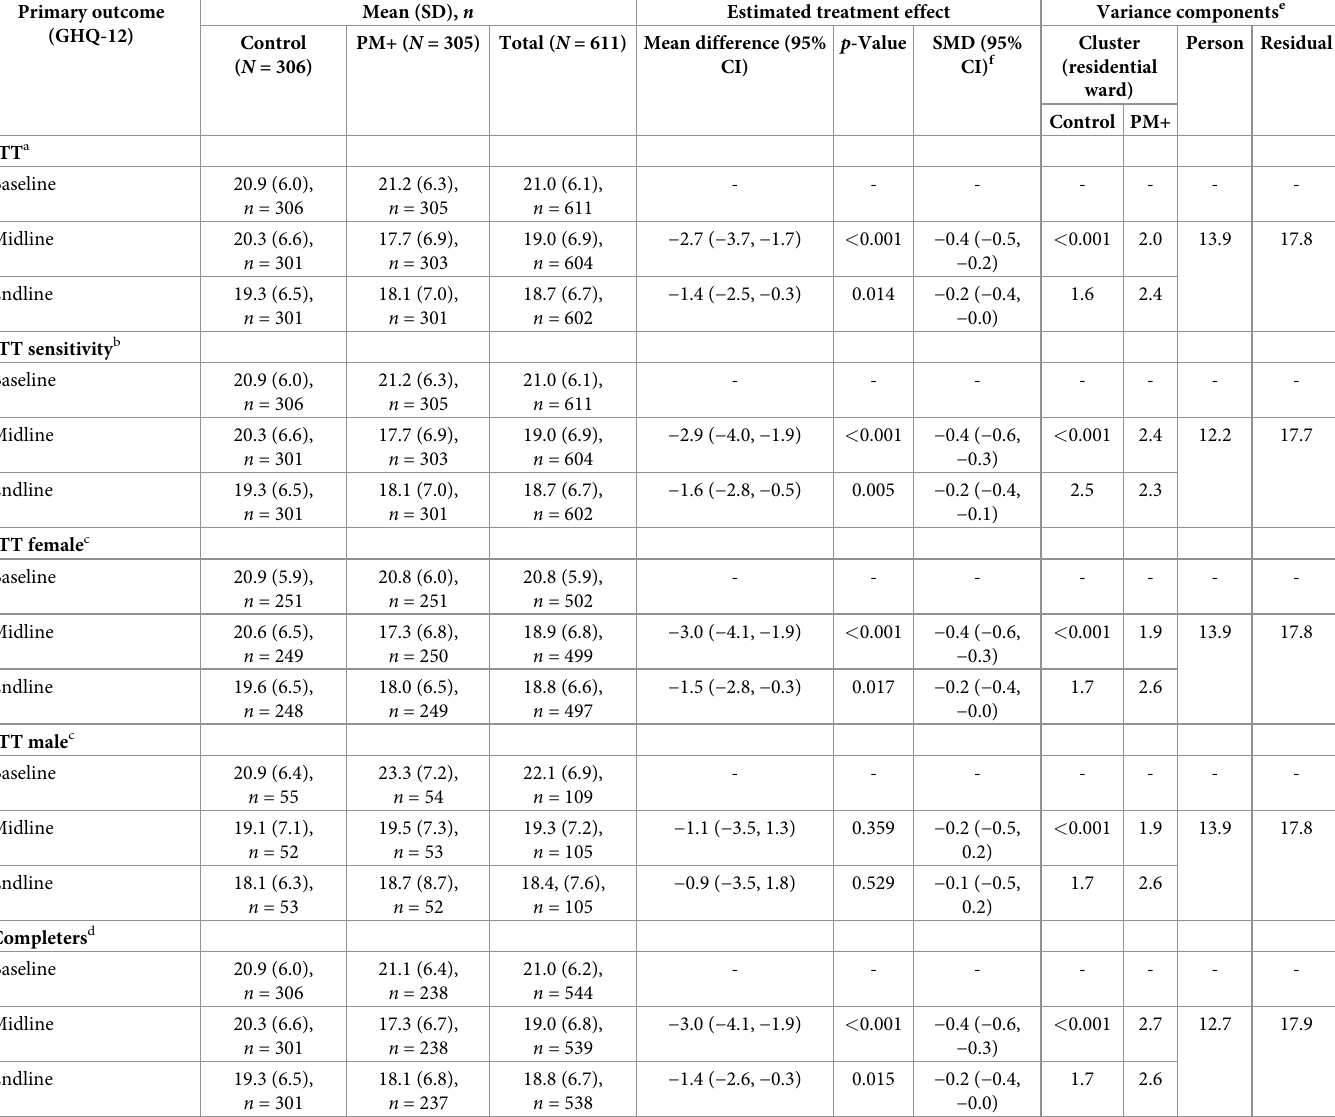
Table 3. Intervention effects (mean differences and 95% confidence intervals) on primary outcome: psychological distress measured with the GHQ-12. Primary outcome